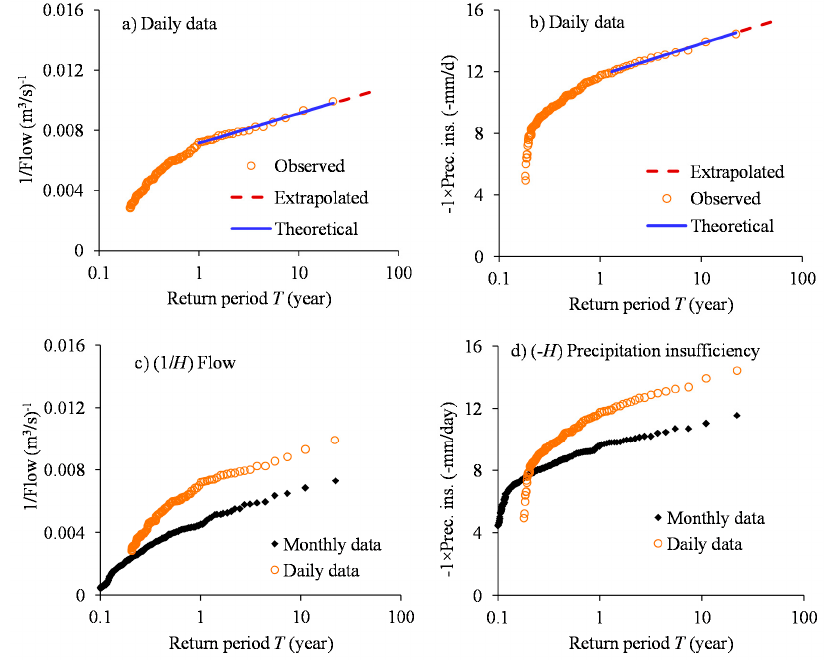
Figure 4. Exponential distribution calibrated to: ( a ) (1/ H ) low flow events over the period 1965–2002 at Khartoum; and ( b ) ( − H ) precipitation insufficiency (Prec. ins.) for the period 1965–2002 over the Blue Nile basin. Comparison of: ( c ) (1/ H ) low flow; and ( d ) ( − H ) precipitation insufficiency quantiles are based on daily and monthly data. The horizontal axis of each chart is based on logarithmic scale.